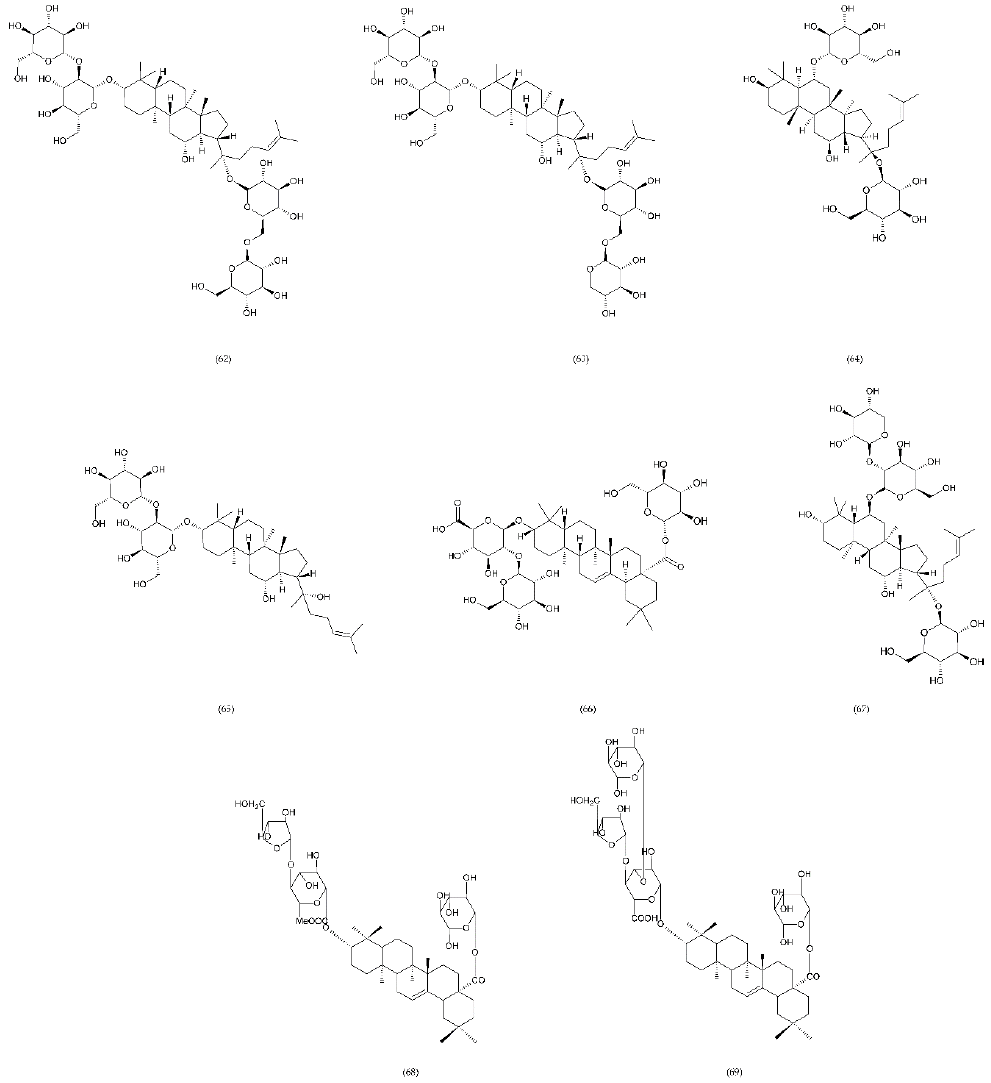
Figure 19. Chemical structure of saponins: ginsenoside rb1 (62), ginsenoside rb3 (63), ginsenoside rg1 (64), ginsenoside rg3 (65), ginsenoside Ro (66), notoginsenoside R1 (67), Panax bipinnatifidus, araloside A methyl ester (68), and Panax bipinnatifidus stipuleanoside R2 (69).